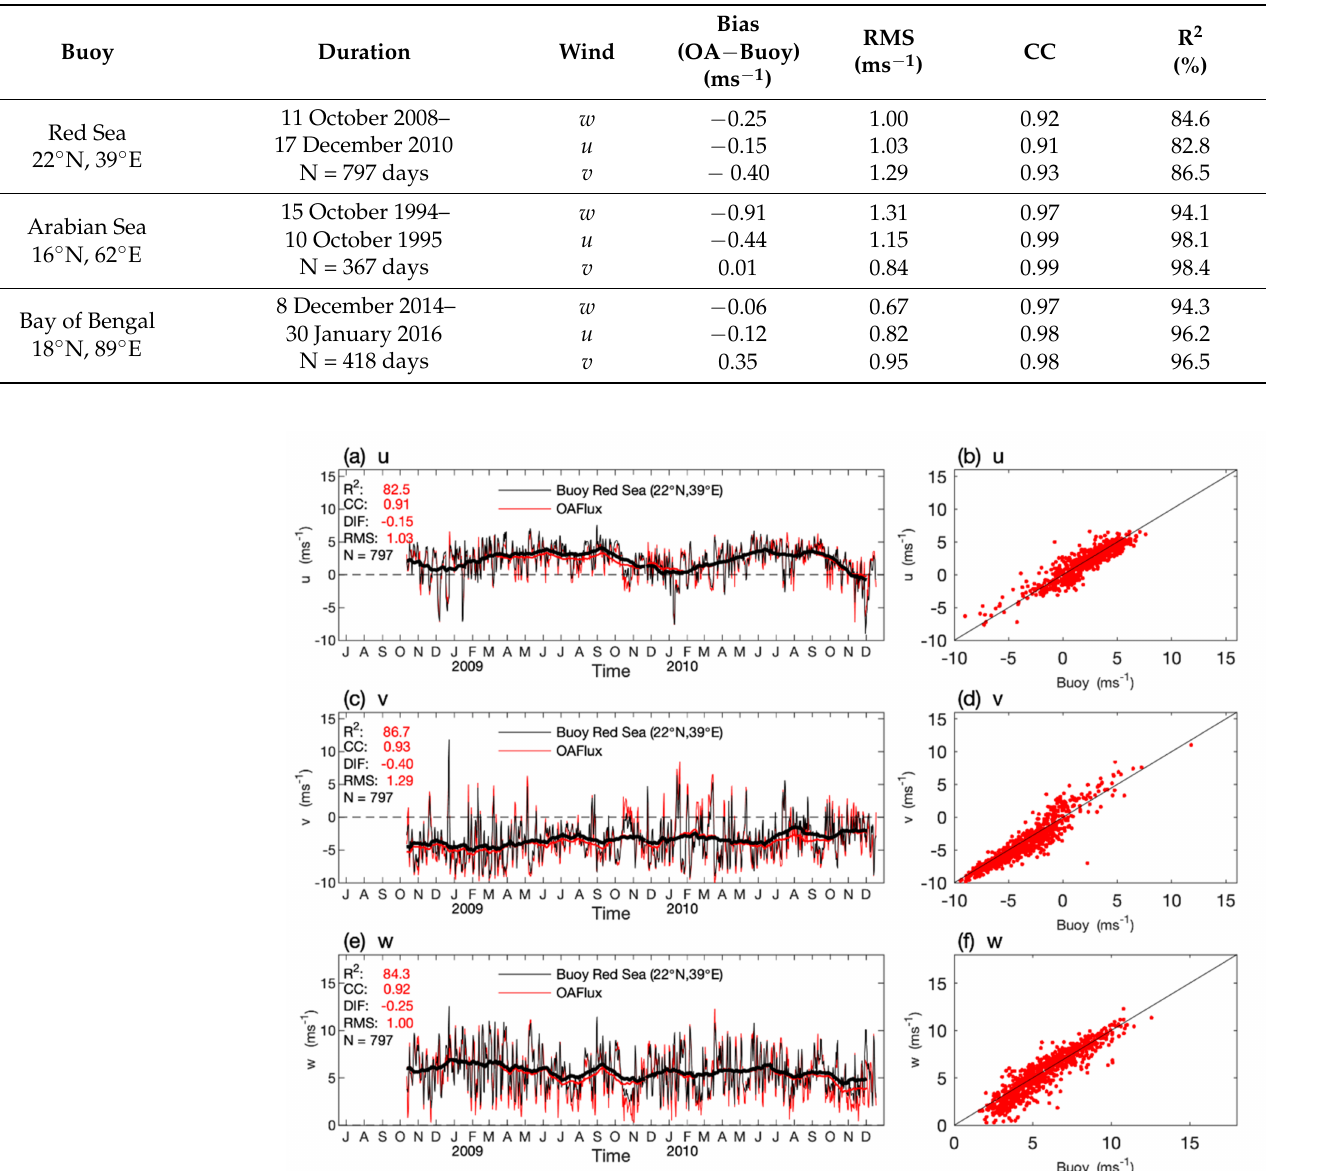
Table 3. Statistics of the OAFlux-HR comparison with three selected buoys.